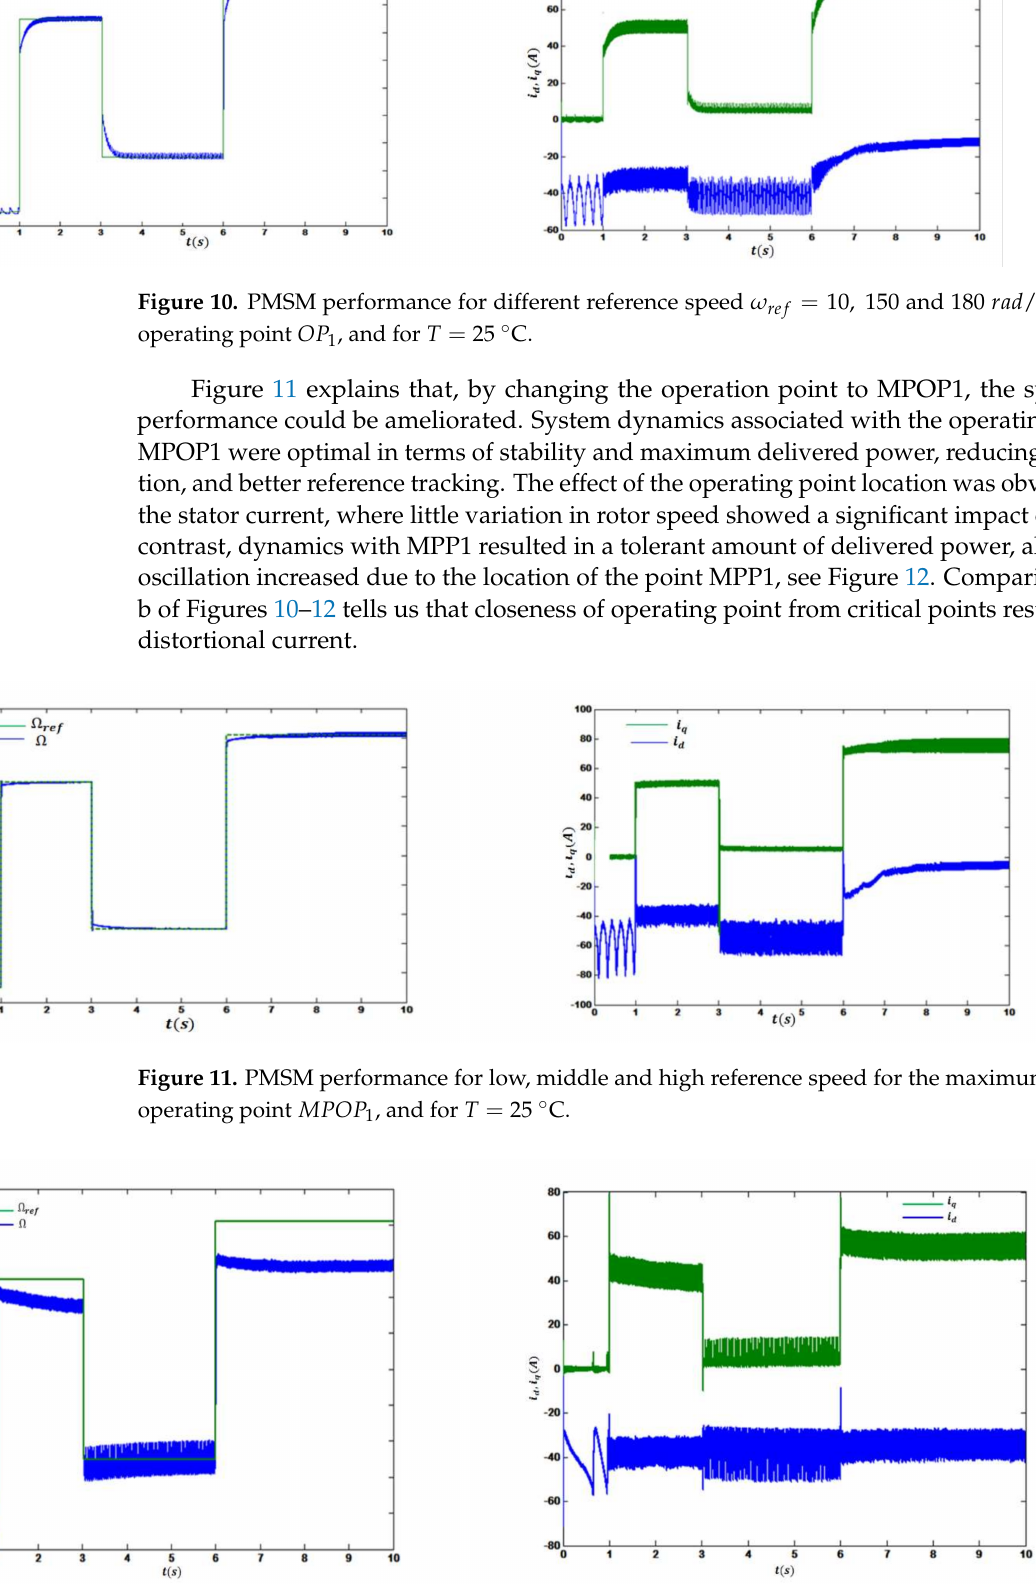
Figure 12. PMSM responses for the maximum power point MPP 1 , and for T = 25 ◦